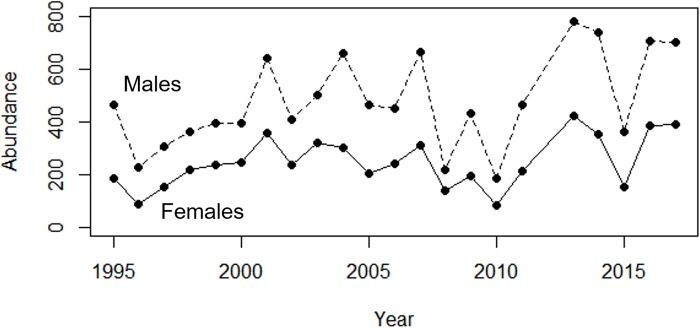
Number of migrating adult salamanders across the 23-year study period.Trends are shown for both males (dashed line) and females (solid line).